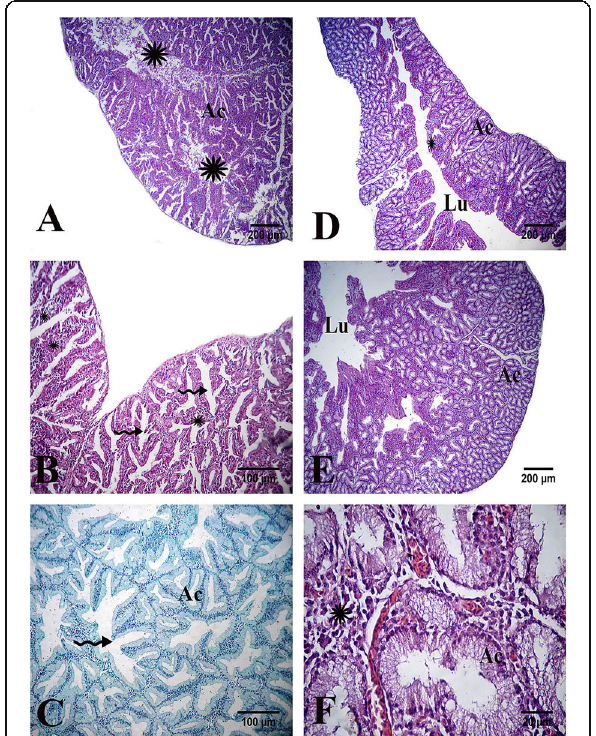
Fig. 10 Light micrograph of the HG of ibis ( A , B , C ) and pigeon ( D , E , F ) showed the secretory acini (Ac), lumen of collecting duct (Lu), irregular lumina (zigzag arrows), and note the distribution of